Question: What type of chart is this?
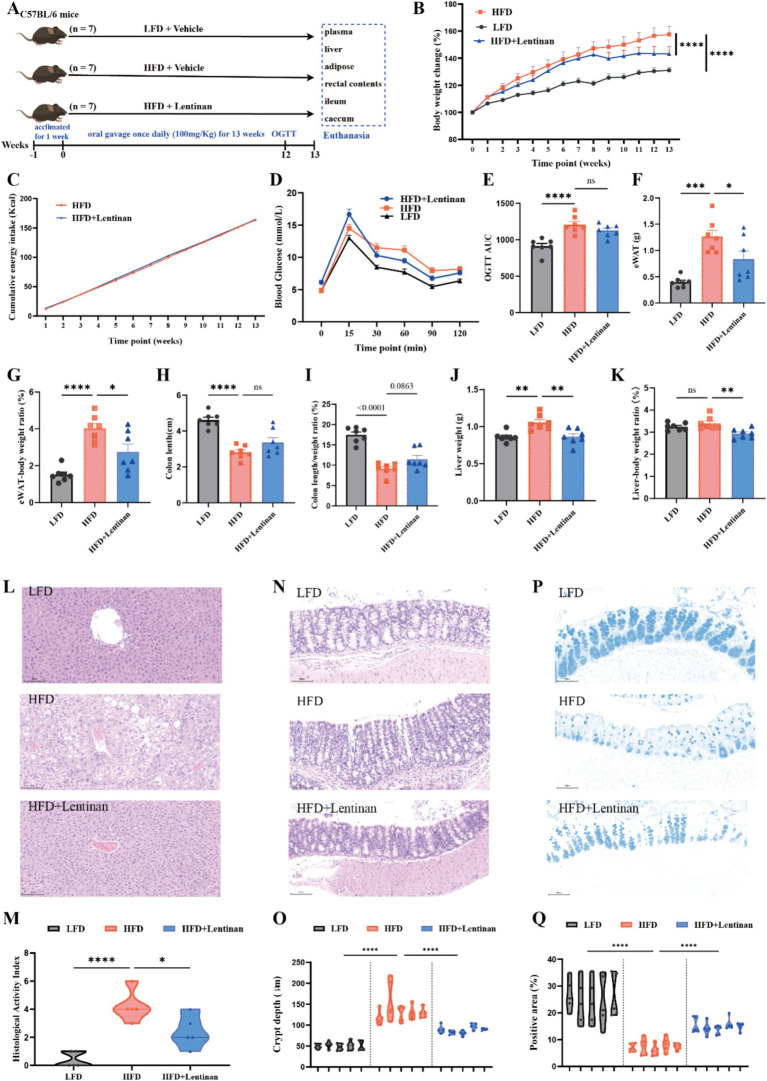
Answer: line